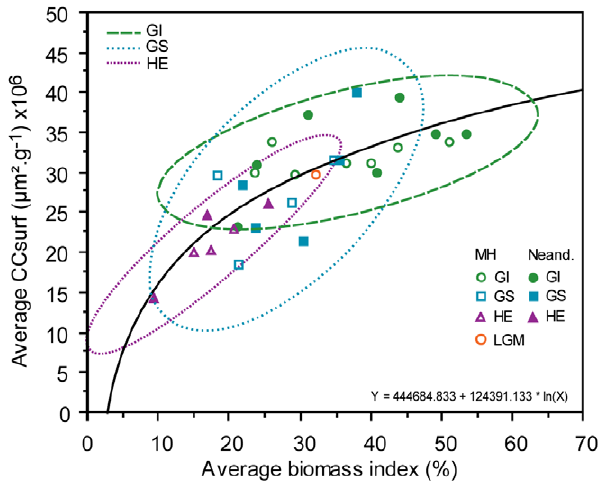
Figure 3. Average surface area of microcharcoal concentration (Average CCsurf) of core MD95-2042 versus average biomass index (Average biomass index) for each Greenland Interstadial (GI) and Stadial (GS) including Heinrich Stadials (HSs). LGM: Last Glacial Maximum. The biomass index for core MD95-2042 is determined by the sum of pollen percentages of Ericaceae and open Mediterranean forest. MH: Modern Humans, Neand: Neanderthals. The confidence ellipsoid at 95% is reported for each GI, GS and HS.